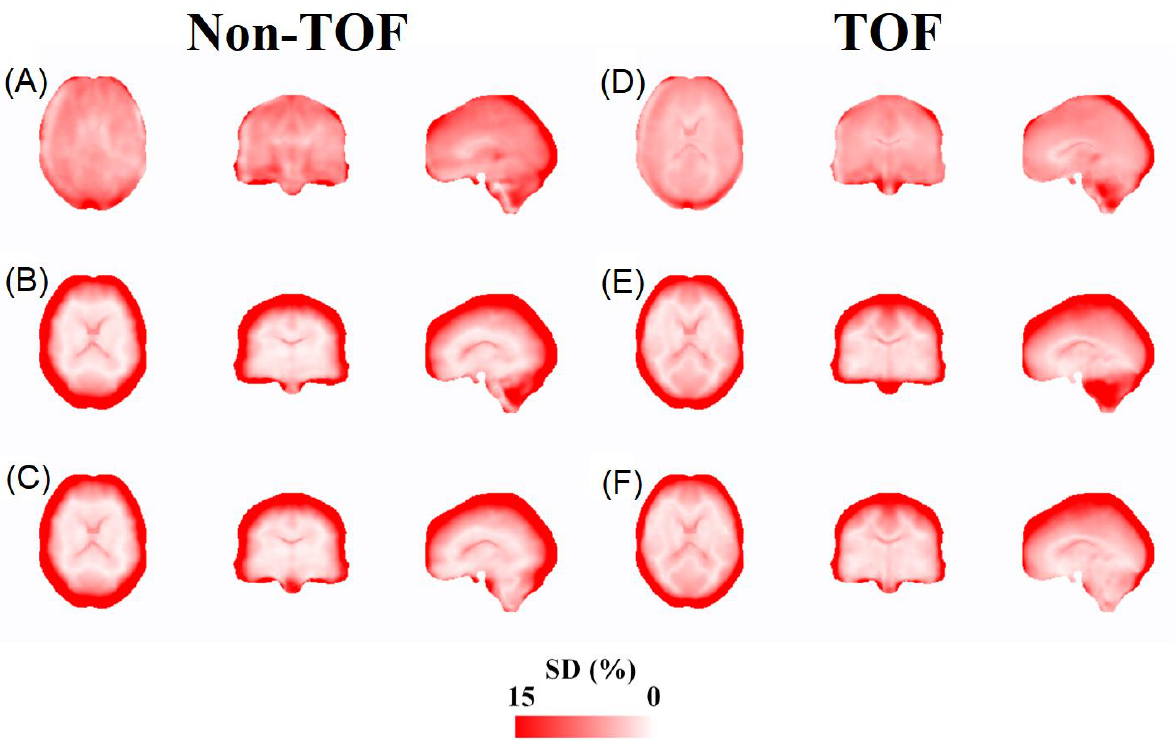
Figure 7. Bias standard deviation images with all the methods. Small local improvements can be seen with the TOF reconstruction with a systematic reduction of standard deviation throughout the brain. ( A ) 3−class MRAC, ( B ) 2−class MRAC, ( C ) 2−class MRAC without air cavities using non−TOF